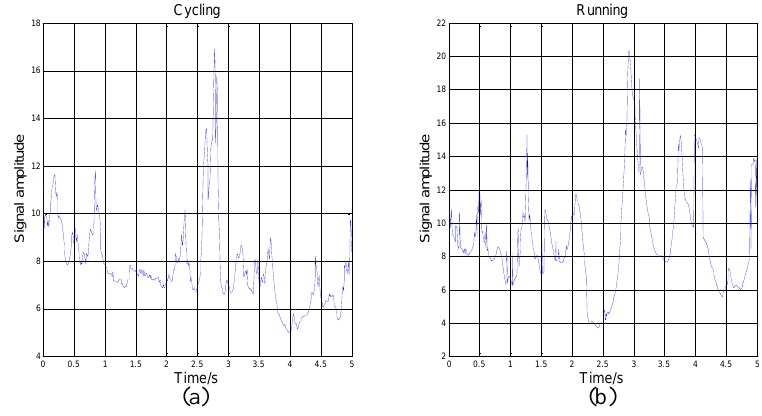
Figure 6. Two similar IE of two different types of activities. ( a ) The IE of cycling data; ( b ) The IE of running data. All data come from the z-axis of the accelerometer on the